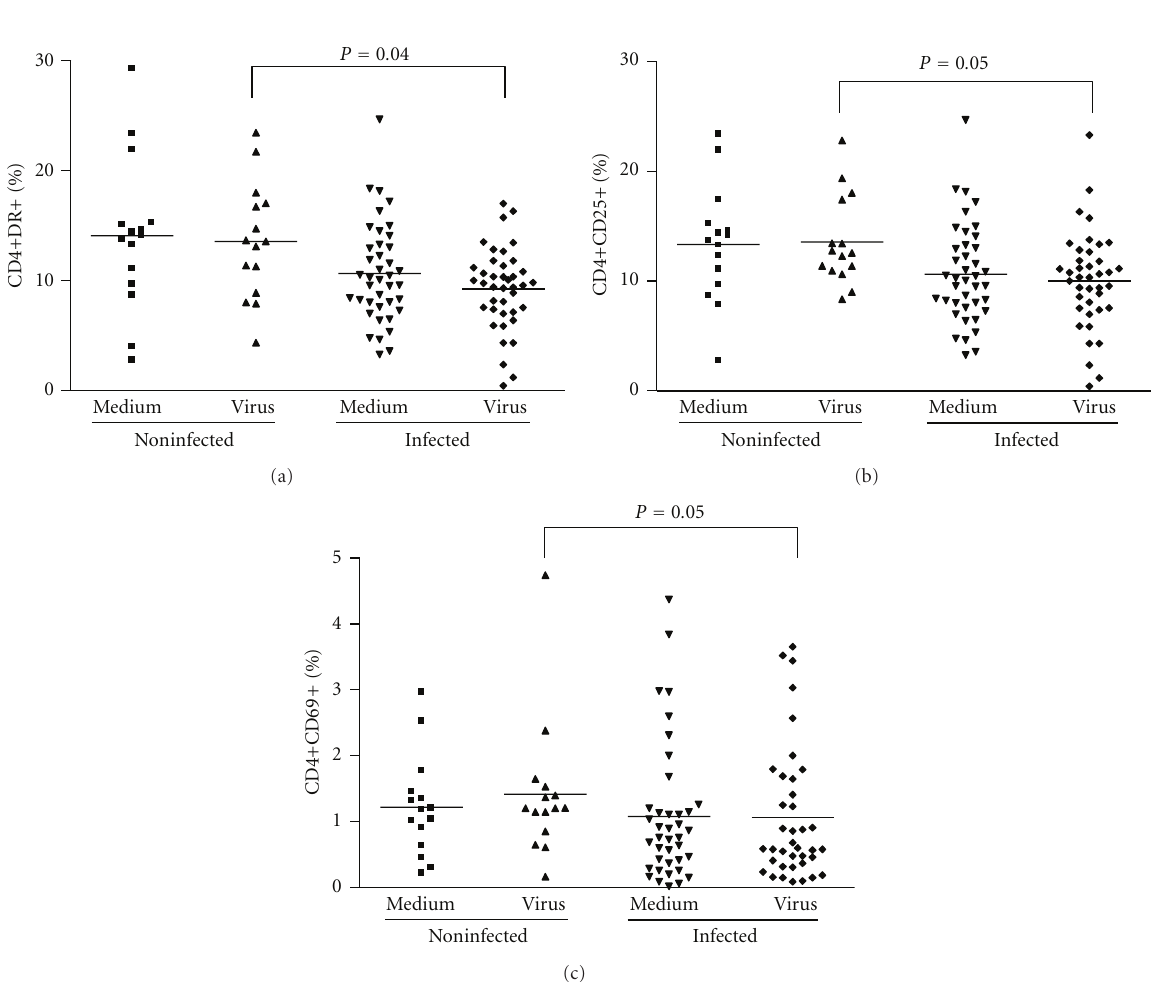
Figure 4: CD4 + T-cell activation status in PBMCs from individuals infected or not by zoonotic Vaccinia virus. Peripheral blood mononuclear cells (PBMCs) from patients infected or not with zoonotic Vaccinia virus were cultured in the presence of UV-inactivated virus or mock- treated (medium). After 72 hours of stimulus, cells were fixed, counted, and the following parameters were evaluated by flow cytometry using specific mouse anti-human antibodies: (a) percentage of CD4 + T lymphocytes expressing HLA-DR surface activation marker; (b) percentage of CD4 + T lymphocytes expressing CD25 surface activation marker; (c) percentage of CD4 + T lymphocytes expressing CD69 surface activation marker. Statistical significance ( P values), based on the median values of each group, is presented on the